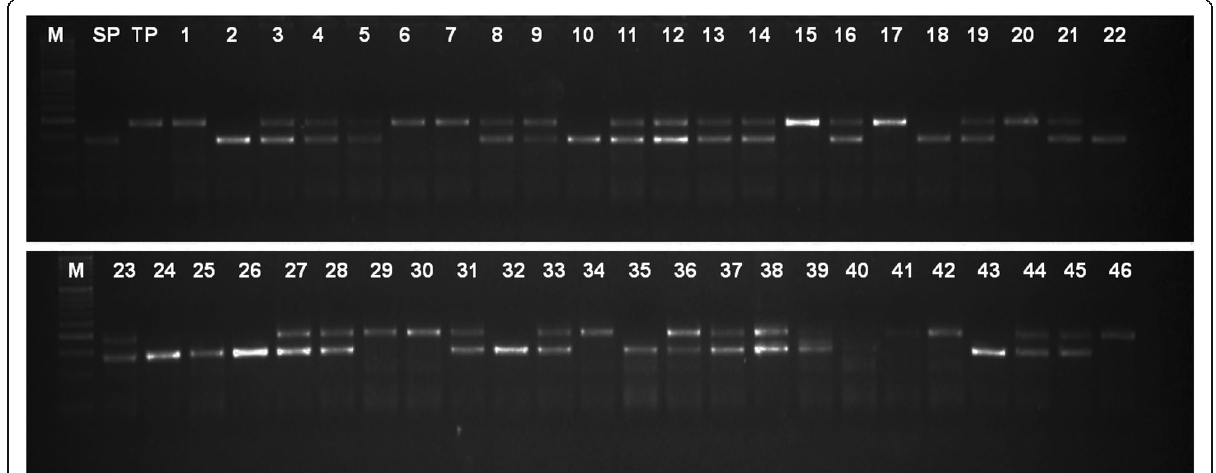
Fig. 4 A representative gel picture showing the segregation pattern of RM 6844 in the F 2 mapping population from the cross, Pusa 1656/HTM- N22. M -50 bp Ladder, SP – Herbicide susceptible parent, Pusa 1656; TP- Herbicide tolerant mutant, HTM-N22; 1 – 46 progenies in F 2 population